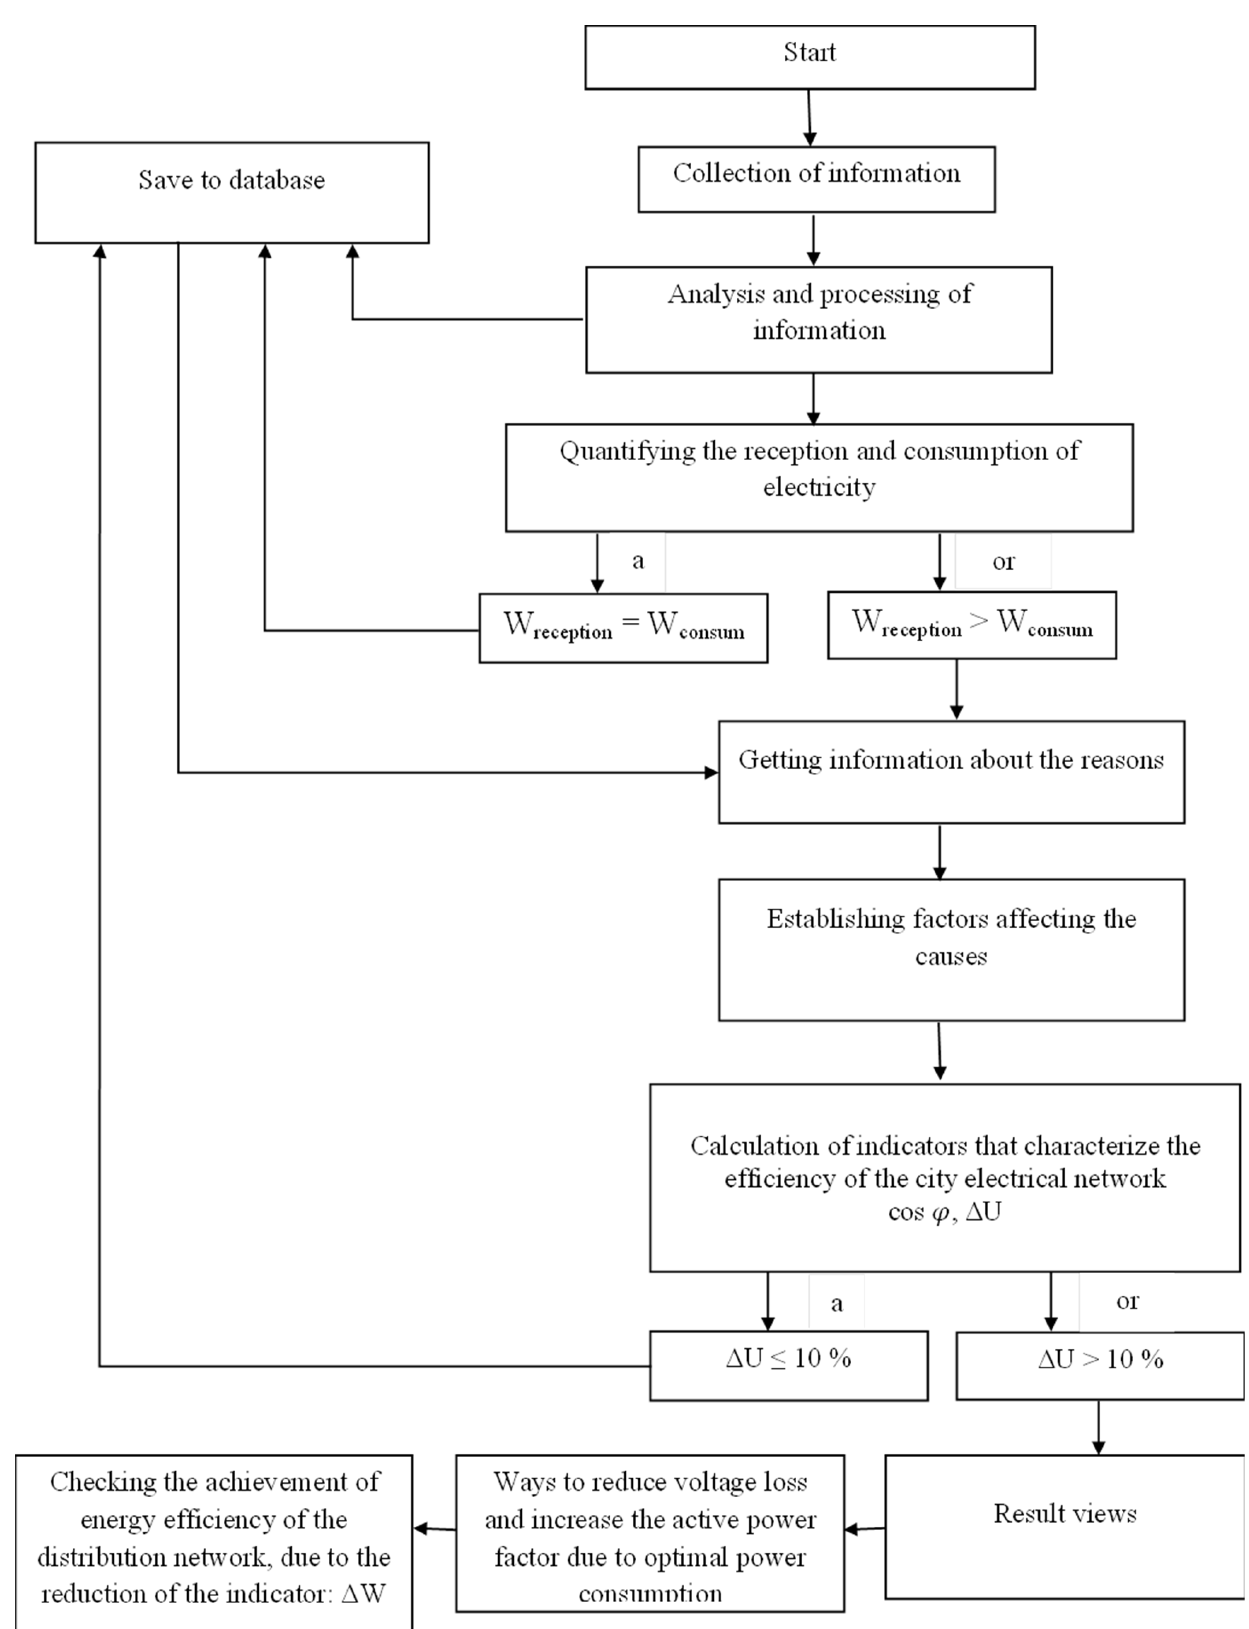
Figure 3. Calculation and assessment algorithm of energy efficiency of the urban distribution power grid by the indicator of power underutilization.